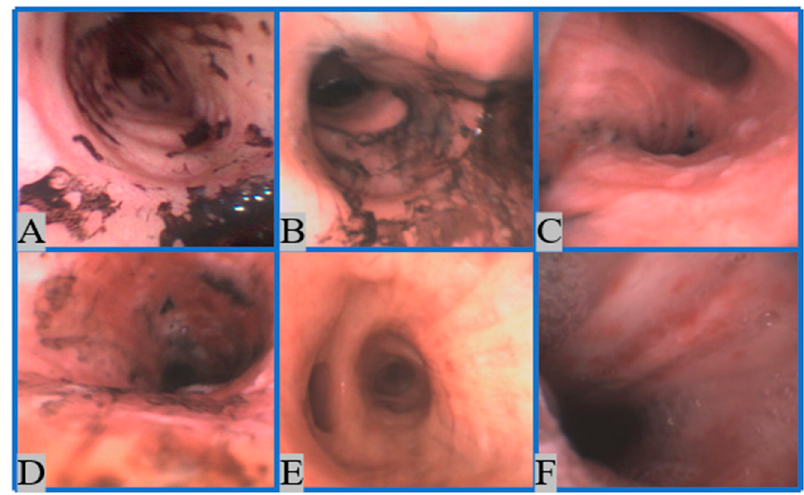
Figure 3. Bronchoscopy images of different degrees based on our proposed grading system. ( A ): degree 1, ( B ): degree 2, ( C ): degree 3, ( D ): degree 4, ( E ): degree 5, ( F ): degree 6.